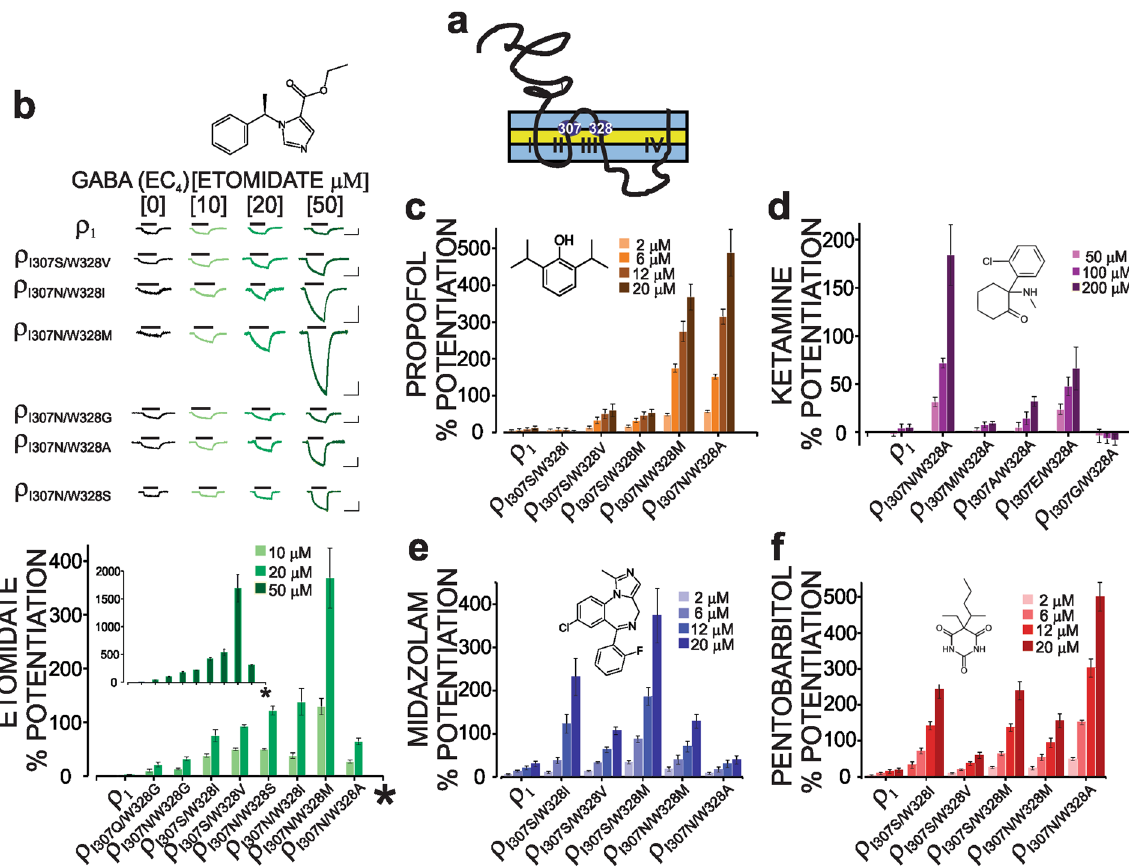
Figure 1. Mutations of the 307/328 residues confer sensitivity to the structurally distinct intravenous anaesthetics to the ρ 1 receptor. ( a ) Schematic representation of the ρ 1 subunit in the membrane bilayer. The positions of the 307 and 328 residues in the TM 2 (II) and TM 3 (III) are delineated. ( b ) Current traces and bar graphs represent the etomidate-dependent potentiation of the ρ 1 307/328 mutants. The lines above the current traces show the duration of the drug application. The vertical and horizontal bar scales denote 100 nA and 100 seconds, respectively. ( c , d , e , f ) The potentiation (as a percent increase) of the EC 4 GABA currents in different ρ 1 307/328 mutants following the propofol-, ketamine-, midazolam-, and pentobarbital-dependent